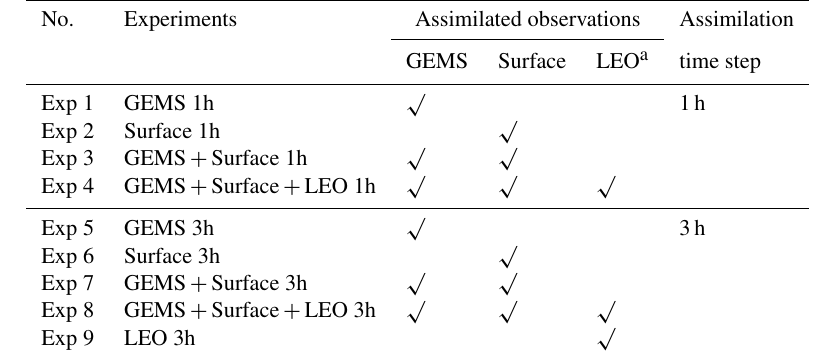
Table 1. Configuration of data assimilation experiments.